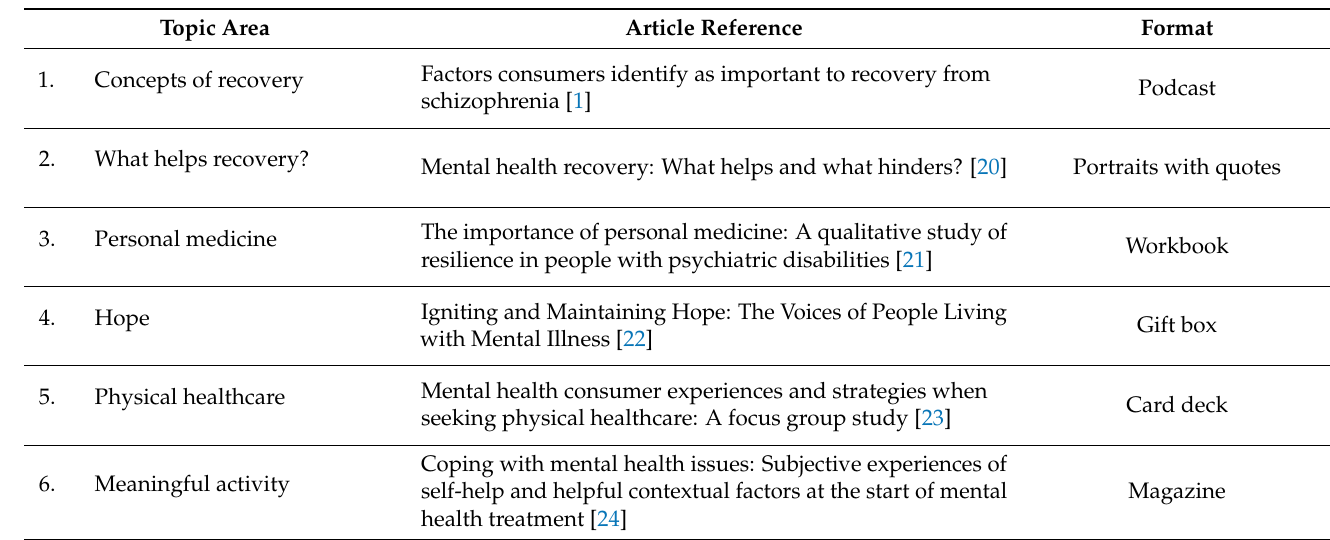
Table 2. Resources